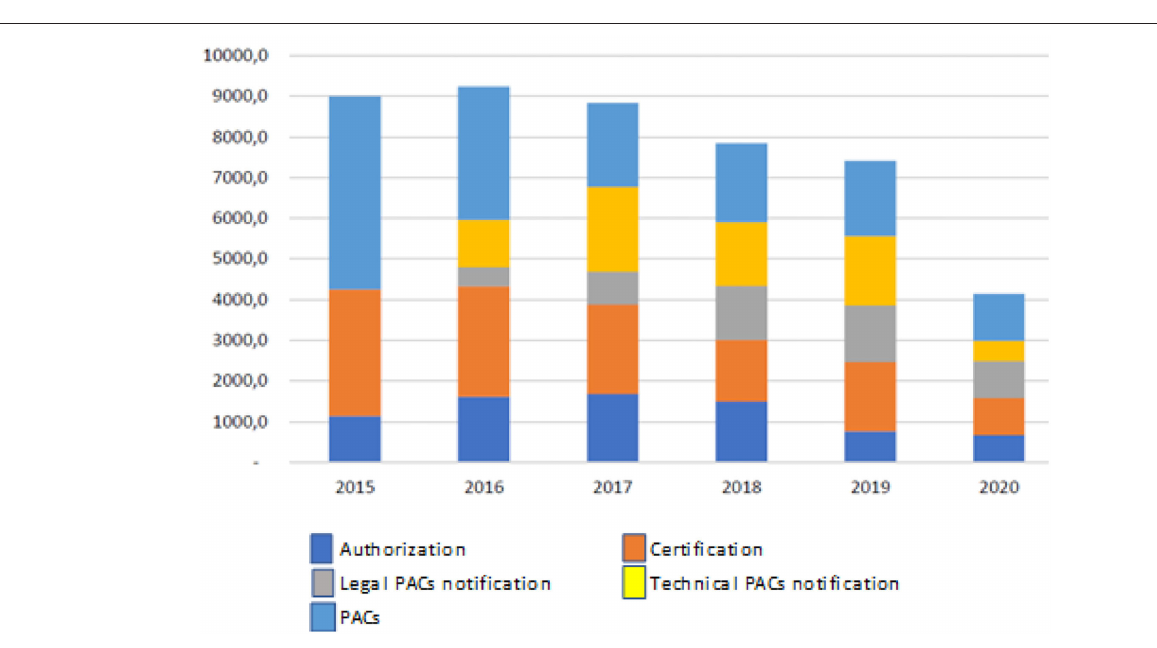
FIGURE 5 | Modification, authorization, and certification of requests for small molecules in Colombia 2015–2020. Source: Invima